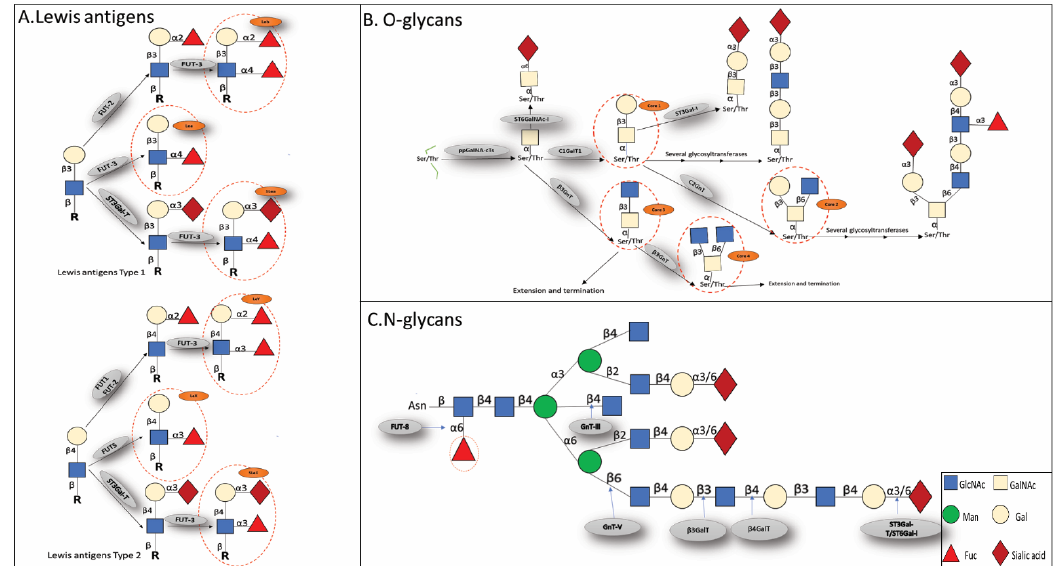
Figure 2. The figure shows some of the important glycan moieties that will be talked about in this study. ( A ) Terminal Lewis and sialylated Lewis ;( B ) O-linked and ( C ) N-linked glycans. Lewis a study. ( A ) Terminal Lewis and sialylated Lewis; ( B ) O-linked and ( C ) N-linked glycans. Lewis a (Lea), Lewis b (Leb), and sialyl Lewis a (SLea) are type 1 Lewis antigens. Lex, Ley, and SLey are type 2 Lewis antigens. Truncated O-glycans such as T, sialyl Tn(STn), or Tn are often present in cancer cells. Additionally, terminal glycosyl epitopes, such as sialyl Lewis(SLe) epitopes, α 2,3-, or α 2,6- linked sialic acid to N—acetyllactosamine(SLN), and fucosylated Lewis (Le) structures may be found at the ends of the glycan chains. The N-glycan structures of both bisecting N-acetylglucosa- mine and β 1,6-branching N-acetylglucosamine compete with one another. In cancer, the balance is often tipped in favor of branching. N-Glycans can also be changed by adding fucose to their center. Gangliosides are sialylated glycosphingolipids. Sialylated glycosphingolipids are known as gangli- osides. GM3, GD3, or GD2 are often overproduced in the abnormal form in cancer. The key enzymes in charge of adding certain sugar residues are also shown in boxes. GalNAc-T1, GalNAc-T2, Gal- NAc-T3, GalNAc-T4, GalNAc-T5, and GalNAc-T6 are among the 20 enzymes that make up the fam- ily of polypeptide N-acetylgalactosamine transferases (ppGalNA-Ts), sialyltransferases (like-galac-